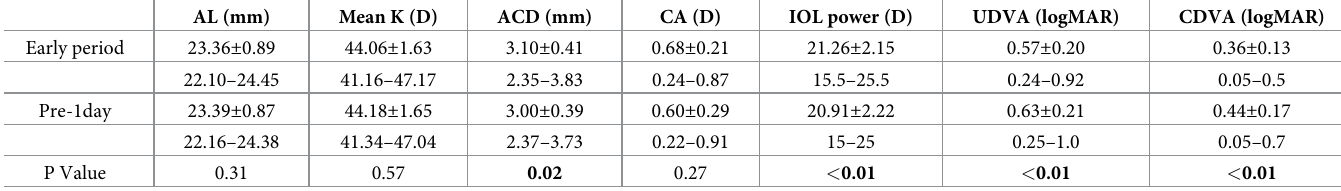
Table 2. Ocular parameters at early period and 1 day